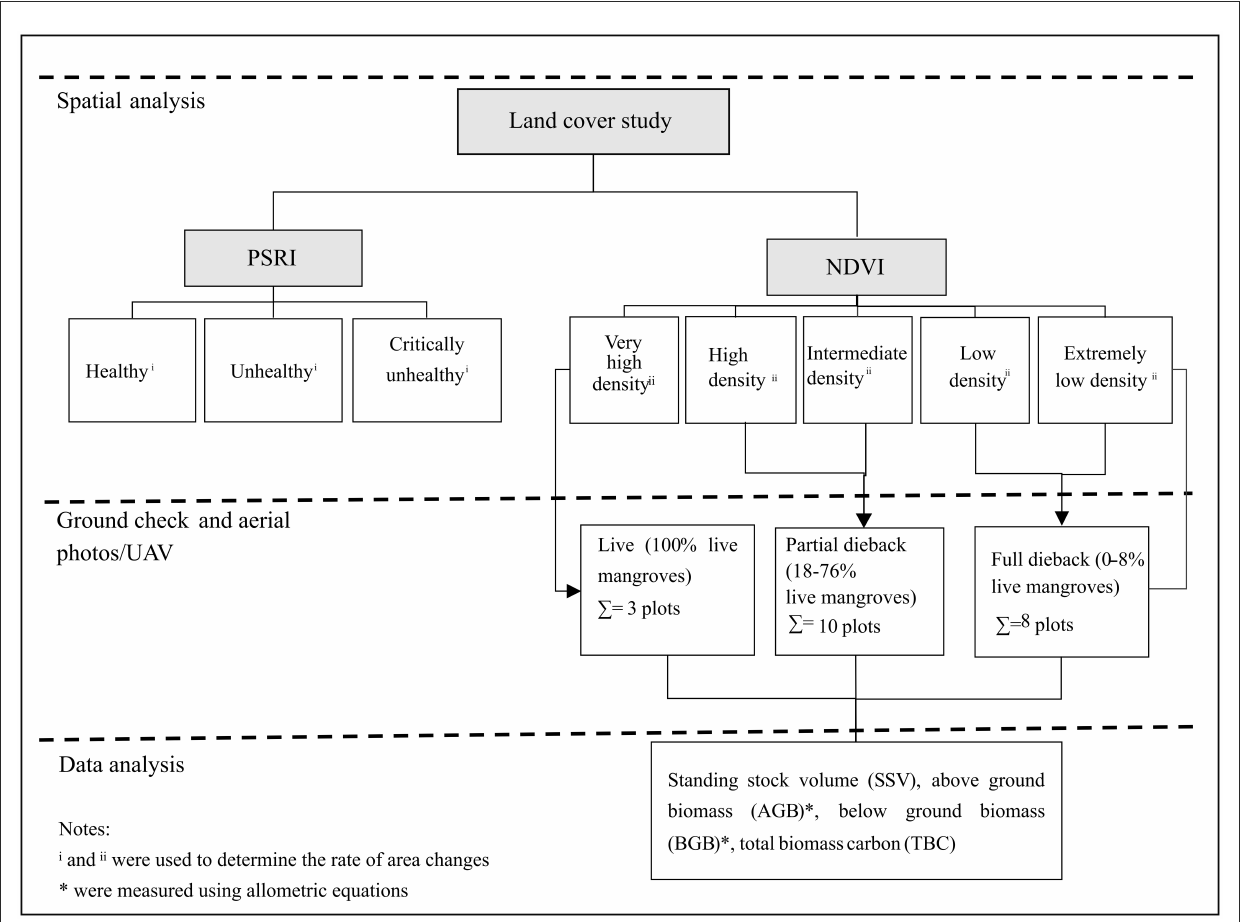
FIGURE2 Scheme for the data collection and analyses of the mangrove dieback in East Lampung,